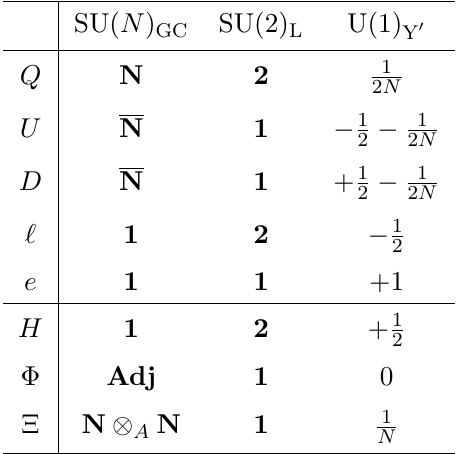
Table 1 . Minimal field content of the model. The scalars Φ , Ξ are solely needed in order to break Grand Color into the SM gauge